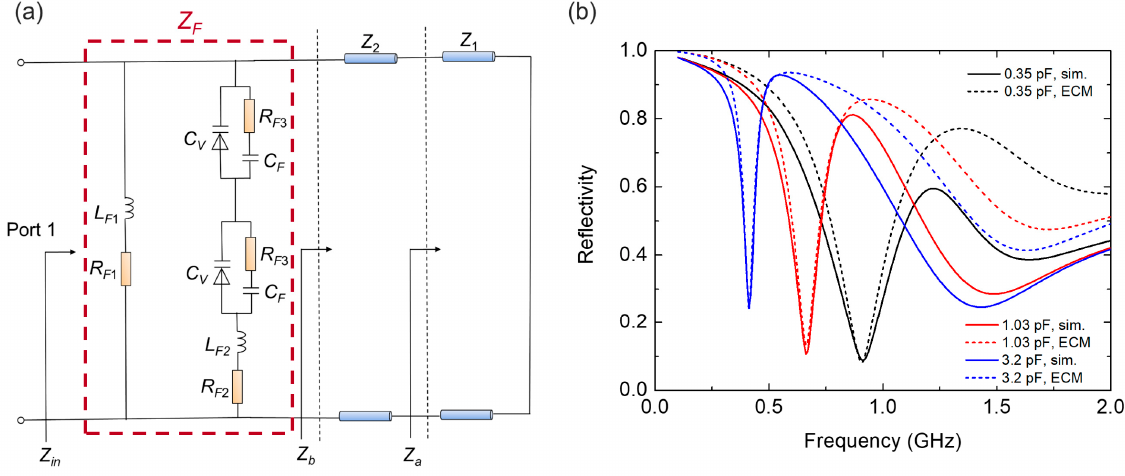
Figure 5. ( a ) The equivalent circuit model of the absorber. ( b ) Comparison of the reflection coefficient between the CST simulation and ECM calculation.